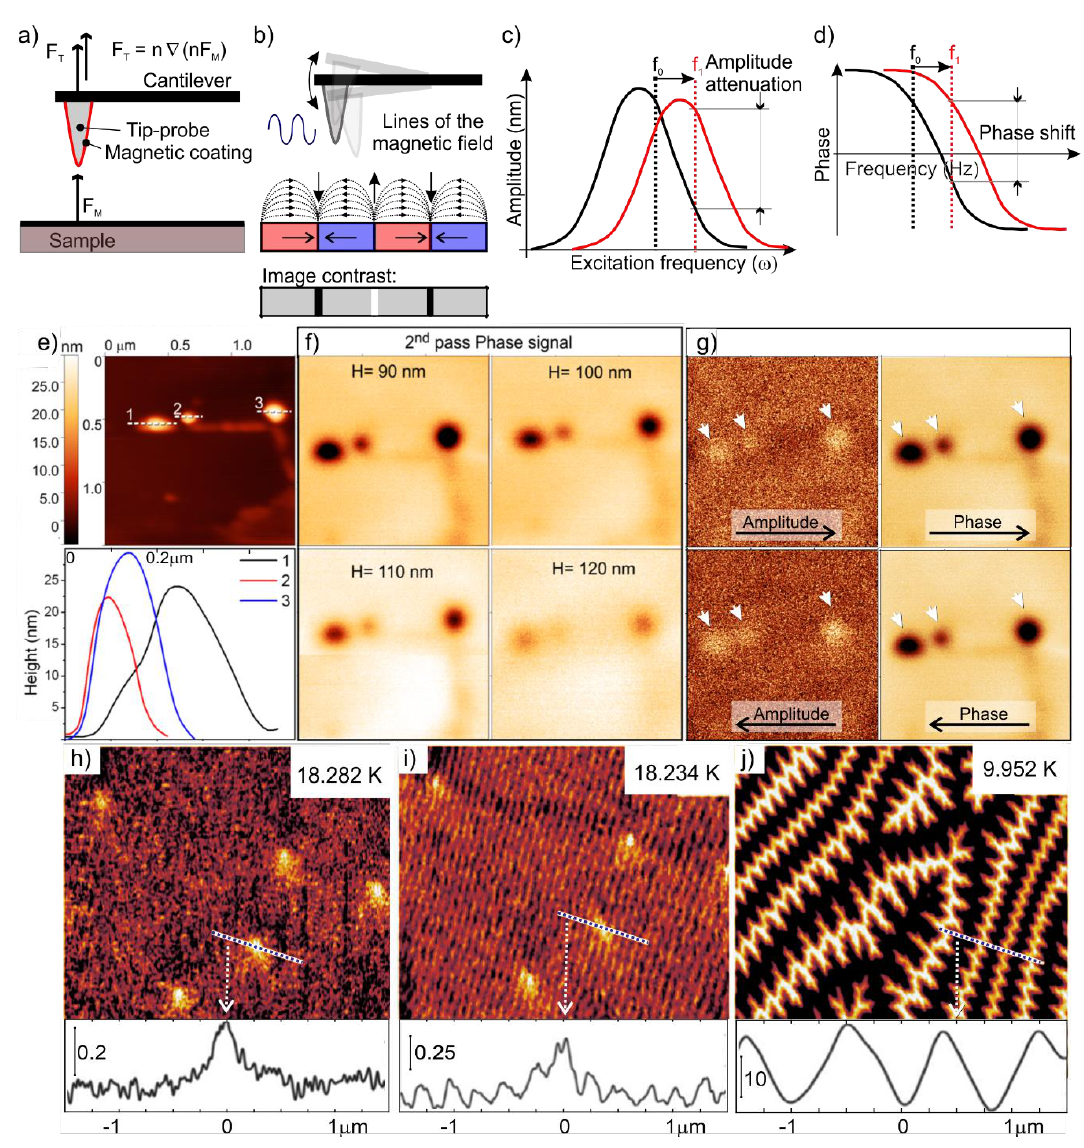
Figure 14. ( a ) Principles and ( b ) forces acting between the tip and the magnetic surface in MFM; ( c ) phase and ( d ) amplitude shifts associated with the long-range magnetic interactions; ( e ) topography signal (top panel) and height profiles (bottom panel) of pyrolyzed magnetic chitosan nanoparticles imaged on the freshly cleaved mica support; ( f ) magnetic force microscopy (MFM) phase shift images obtained at various lift heights (H = 90, 100, 110, and 120 nm); ( g ) forward and backward amplitude and phase maps obtained for H = 90 nm above the sample surface (obtained at constant height of 90 nm). Reproduced with permission from [65], copyright (2016) by American Chemical Society; ( h – j ) MFM maps acquired at T = 18.28 K, T = 18.23 K, and T = 9.95 K without a magnetic field. In the bottom insets, profiles of the phase signal along selected lines of the three structures are illustrated. Panels ( h – j ) are adapted from [165], published by American Association for the Advancement of Science,